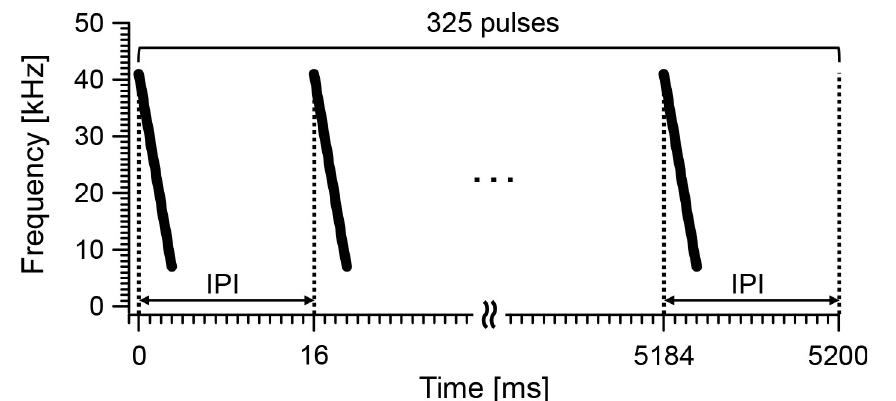
Fig 2. Synthetic echolocation signal. Downward linear FM pulses (pulse duration: 3 ms; frequency: 41–7 kHz; number of pulses: 325 pulses; sampling frequency: 96 kHz) with short IPIs (16 ms) were used as the synthetic echolocation signal; this mimicked buzz signals emitted by bats before capturing their